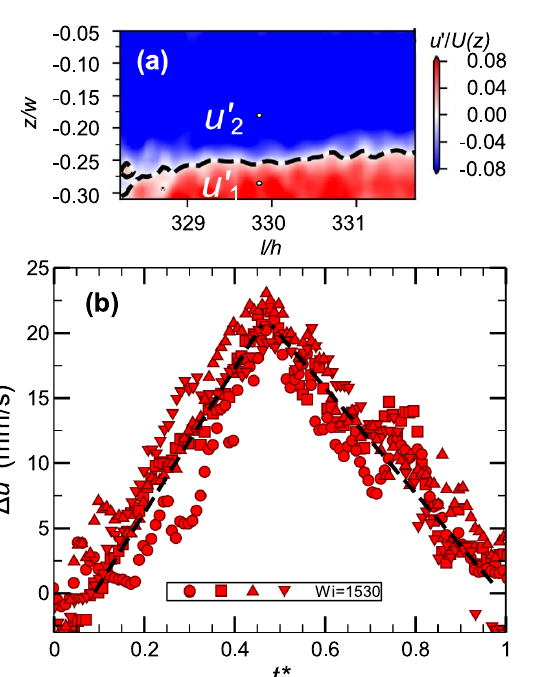
Figure 5. Temporal dynamics of streaks at l / h =330 at Wi =1530 in ET. ( a ) Span-wise-separated two points for calculation of (cid:31) u ′ = u ′ 1 − u ′ 2 . ( b ) Four runs of (cid:31) u ′ for one cycle period normalized by the elastic wave frequency.